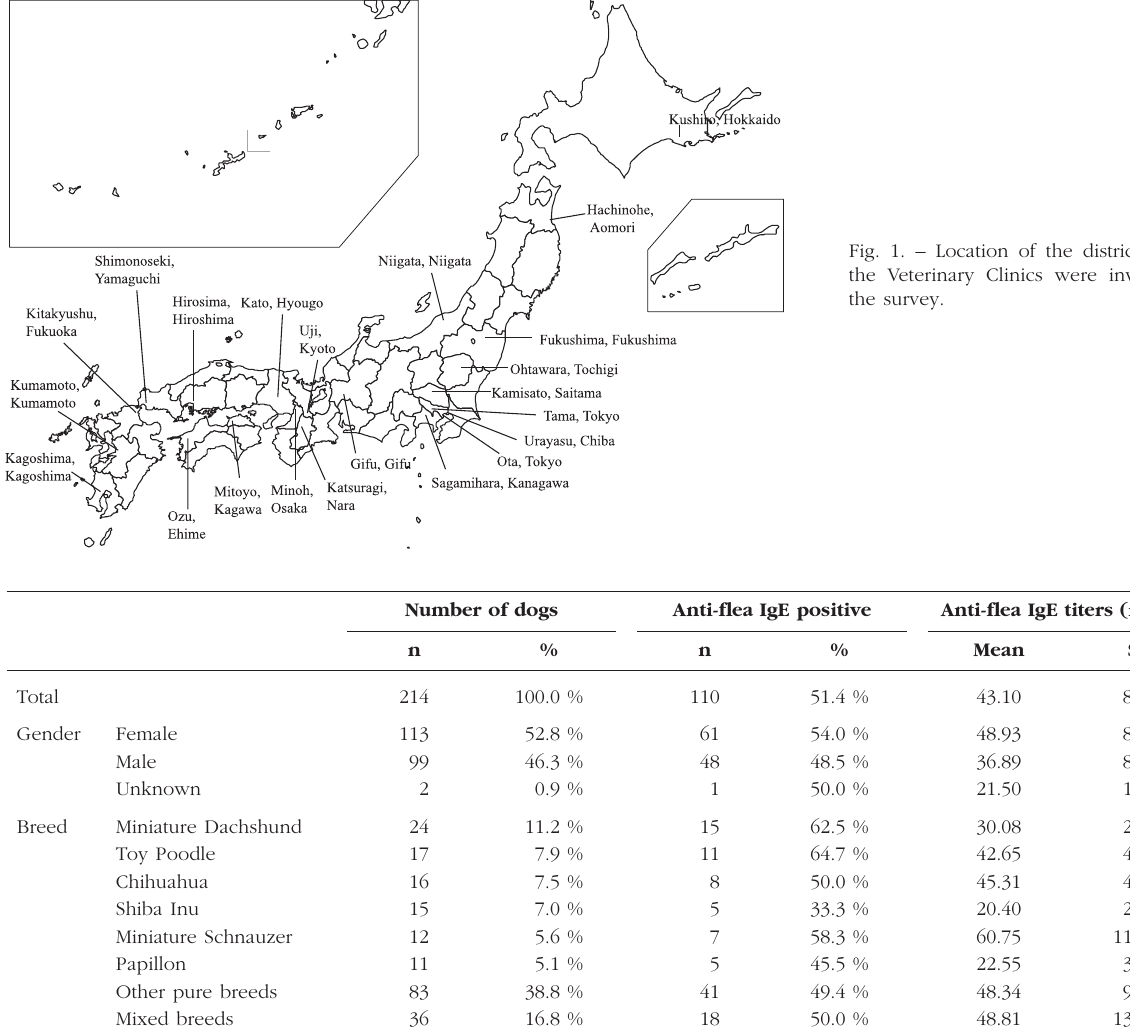
Fig. 1. – Location of the districts where the Veterinary Clinics were involved in the